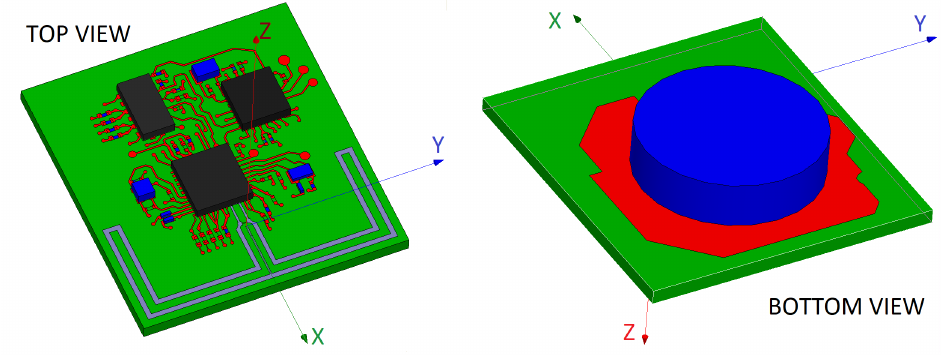
Figure 9. Example of an antenna design employed for realistic simulations. Note: The color of the components is for visual purposes only, and not indicative of the